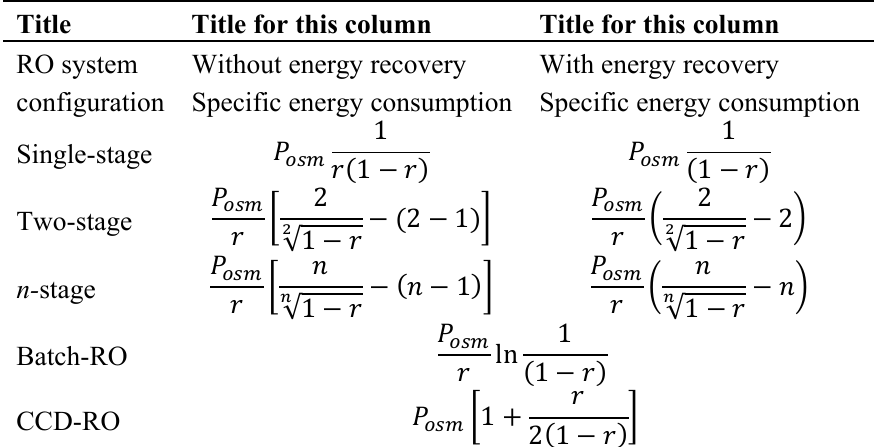
Table 3. Specific energy consumption (SEC) of different BWRO system